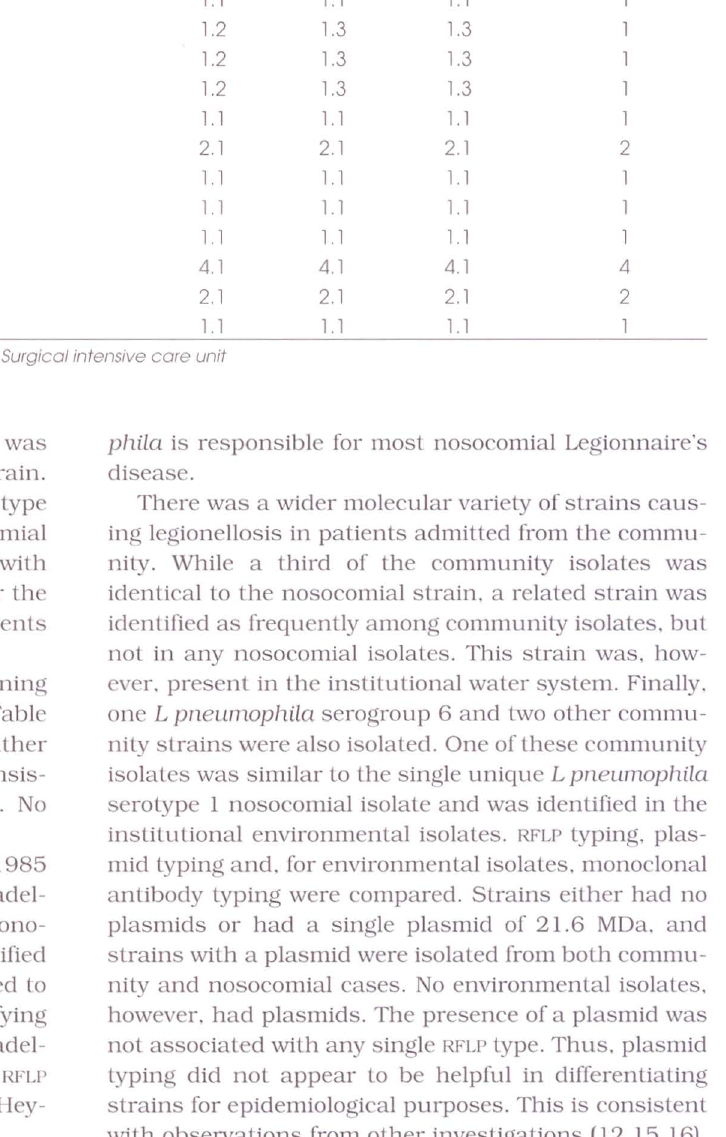
Molecular types and monoclonal antibody subtypes of environmental isolates* of Legionella pneumophila serogroup 1